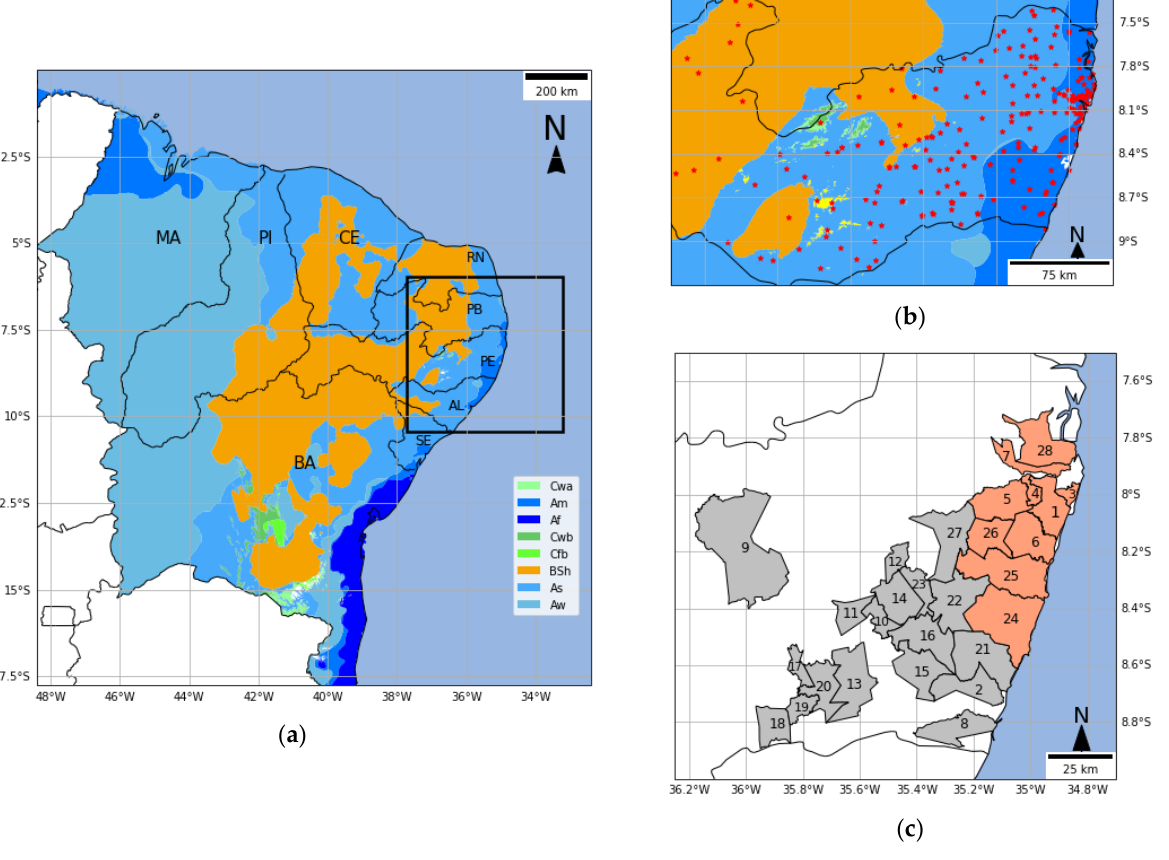
Figure 1. ( a ) Koppen ’ s climate classification for the nine states of NEB (BA — Bahia, SE — Sergipe, AL — Alagoas, PE — Pernambuco, PB — Paraíba, RN — Rio Grande do Norte, CE — Ceará, PI — Piauí, and MA — Maranhão); the black rectangle is the region where the numerical simulations were performed using the WRF model. ( b ) A zoom-in representation of the eastern Pernambuco state; the red stars are the 298 rainfall stations used in the verification of the simulations. ( c ) The 28 monitored municipalities affected by natural disasters in this study (1 — Recife, 2 — Rio Formoso, 3 — Olinda, 4 —